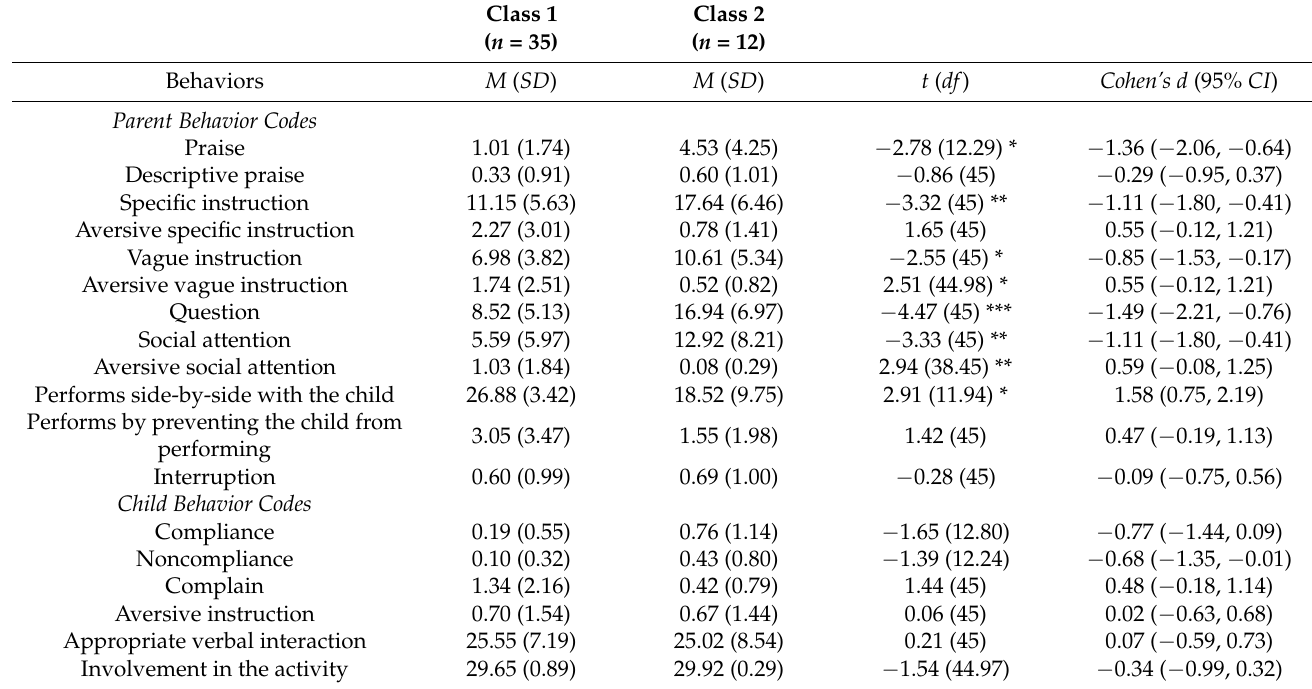
Table 5. Differences between classes in the discrete behaviors assessed by the micro-analytic coding